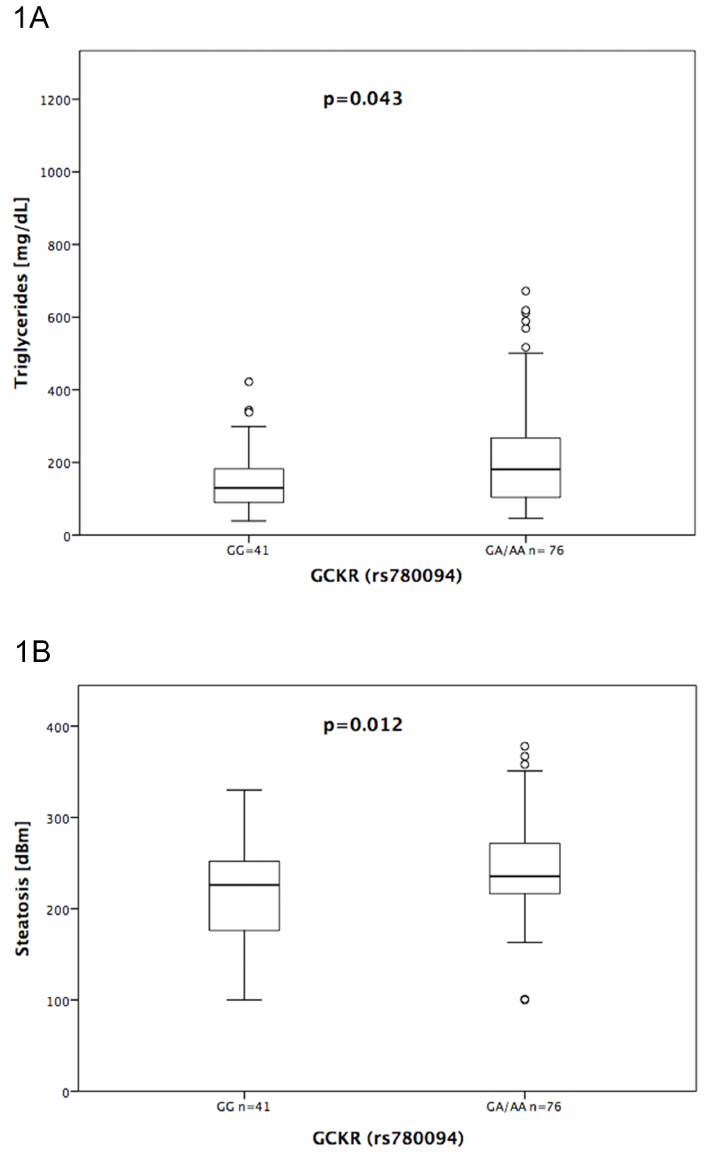
Fig 1. Effects of the GCKR (rs780094) A mutation on hepatic steatosis A) and serum triglyceride levels B) in HIV-positive patients. A : Liver fat assessedby the CAP parameter [dB/m] in GCKR (rs780094) wild type homozygous patients versus carriers of the GCKR (rs780094)A mutation. B : Levels of serum triglycerides [mg/dl] in wild type homozygouspatients versus carriers of the GCKR (rs780094)A mutation. Box and whisker plots indicating medians,10-, 25-, 75, and 90-percentiles as well as individualoutliers.